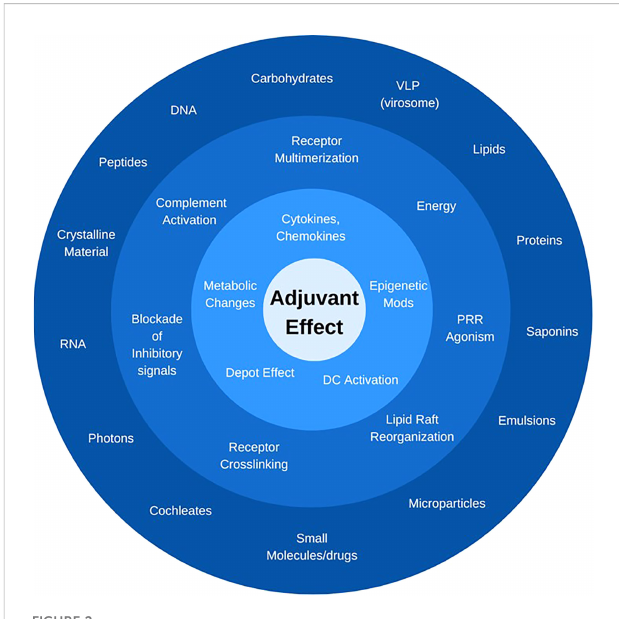
FIGURE 2 What is an adjuvant? Immunostimulators can be de fi ned by their chemical nature and structure ( outer ring ), their activity and receptor through which they signal ( middle ring ), or the downstream cellular and molecular effect they trigger ( inner ring ). The only unifying feature is the ultimate “ adjuvant effect ” , i. e. , the enhancement of adaptive immune responses to a co-delivered antigen. In each category, only representative compounds or signals are